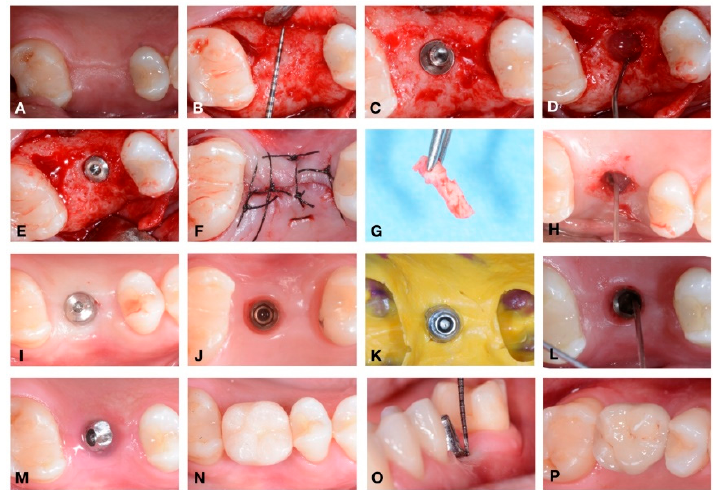
Figure 3. Detail of a complete case performed in this study: from implant placement to the delivery of permanent restoration. ( A–P ). ( A ) Residual crest before incision; ( B ) bone explosion with periodontal probe to underline the residual bone; ( C ) implant just positioned; ( D ) gel inserted into the fixture (T0) ; ( E ) insertion of cover screw; ( F ) suture; ( G ) soft tissue biopsy; ( H ) gel inserted into the fixture after the removal of cover screw; ( I ) healing abutment placed; ( J ) soft tissue before the impression; during this stage the healing abutment was collected for the microbiological analysis (T2) ; ( K ) impression; ( L ) gel inserted before the positioning of abutment; ( M ) definitive abutment location; ( N ) provisional crown; ( O ) probing around implant; ( P ) definitive ceramic restoration delivery.